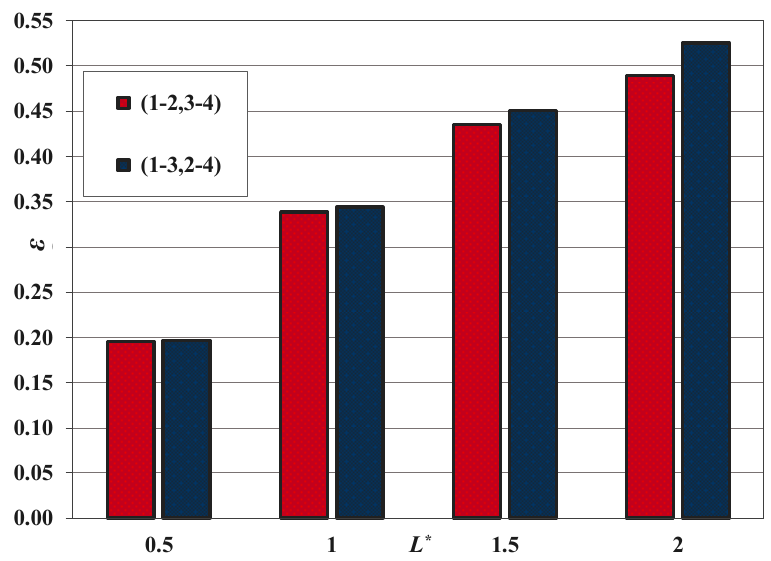
ff ectiveness versus normalized borehole Figure 12. Thermal effectiveness versus normalized borehole length. Figure 12. Thermal e